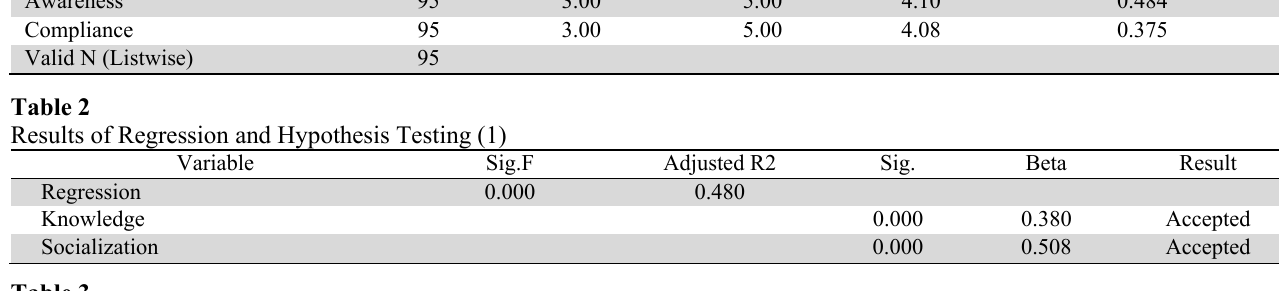
Results of Regression and Hypothesis Testing (2)